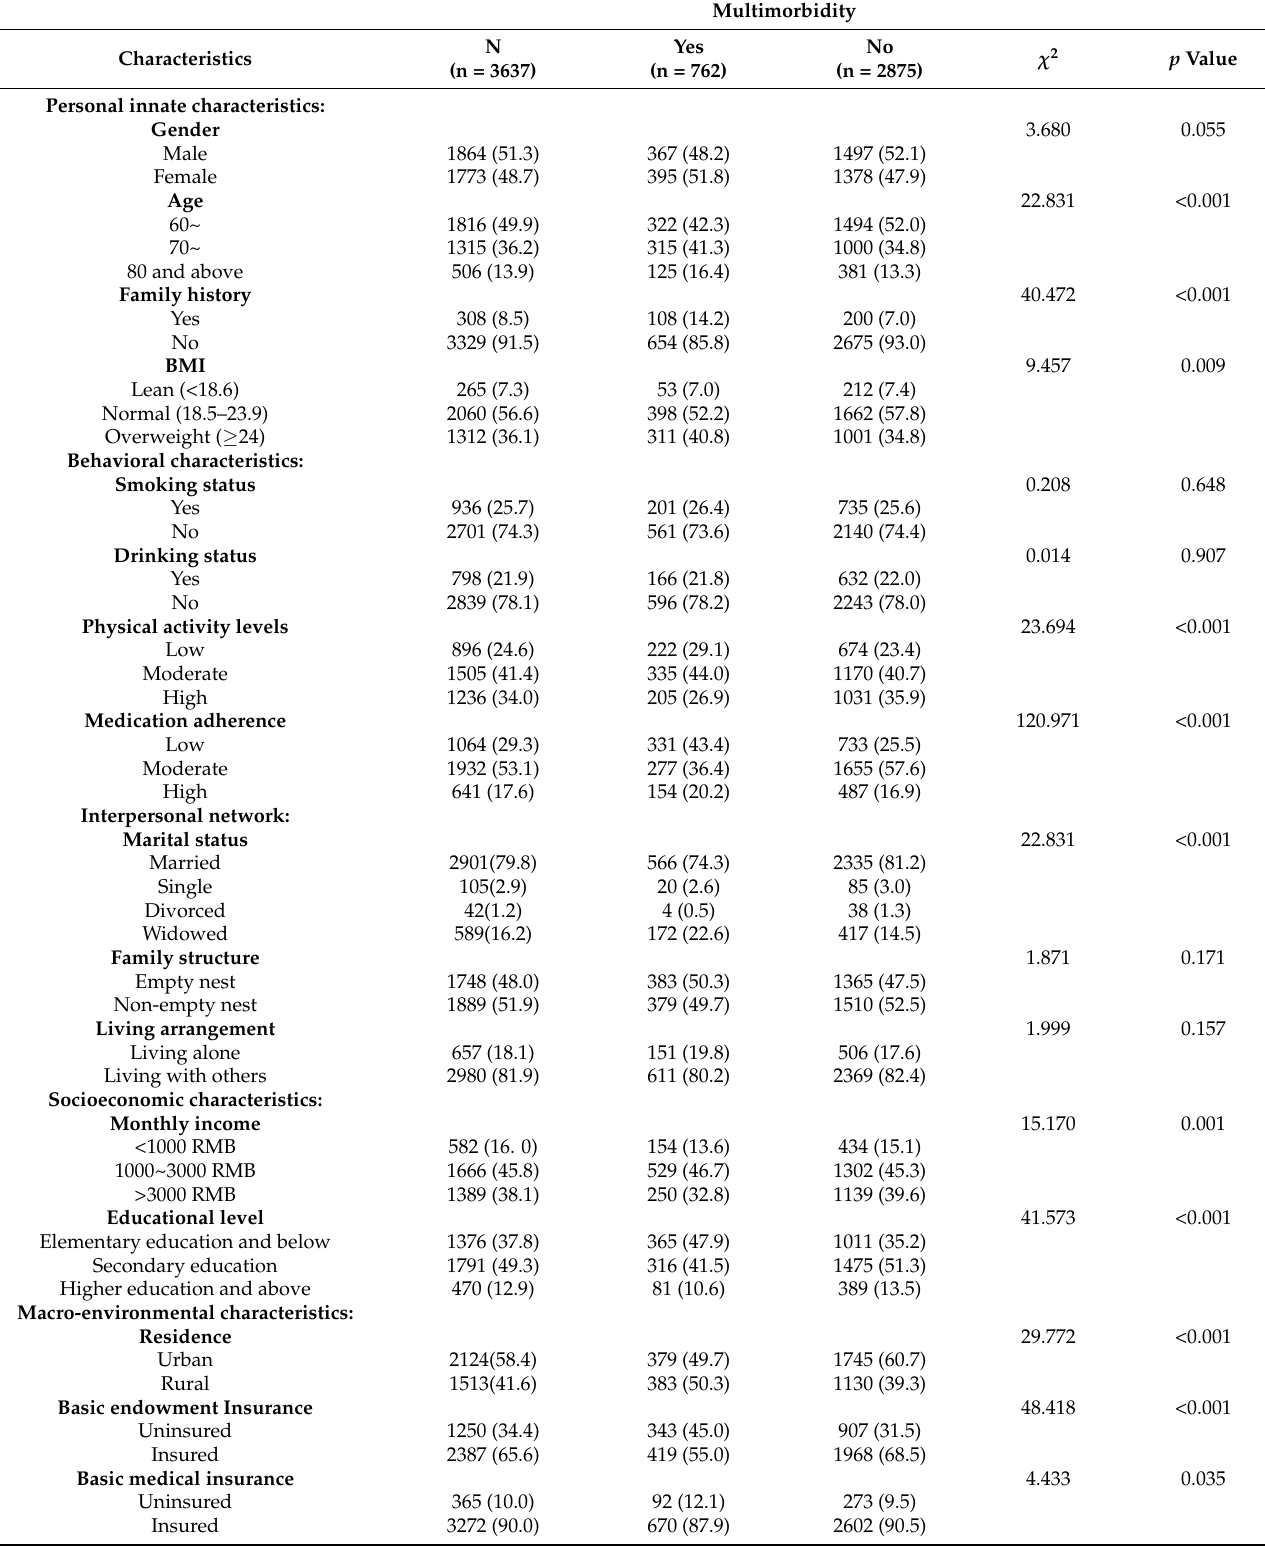
Table 3. Distribution of variables of older adults and group differences in multimorbidity and non-multimorbidity